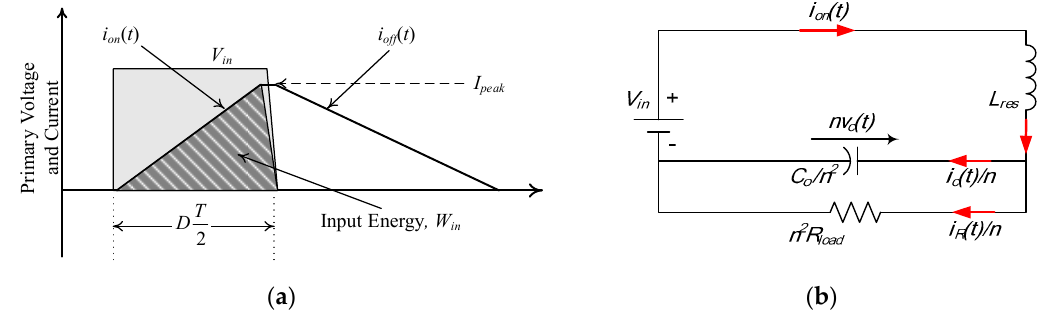
Figure 4. Input Energy During Power Transferring Stage: ( a ) Primary Voltage and Current; ( b ) Equivalent circuit.